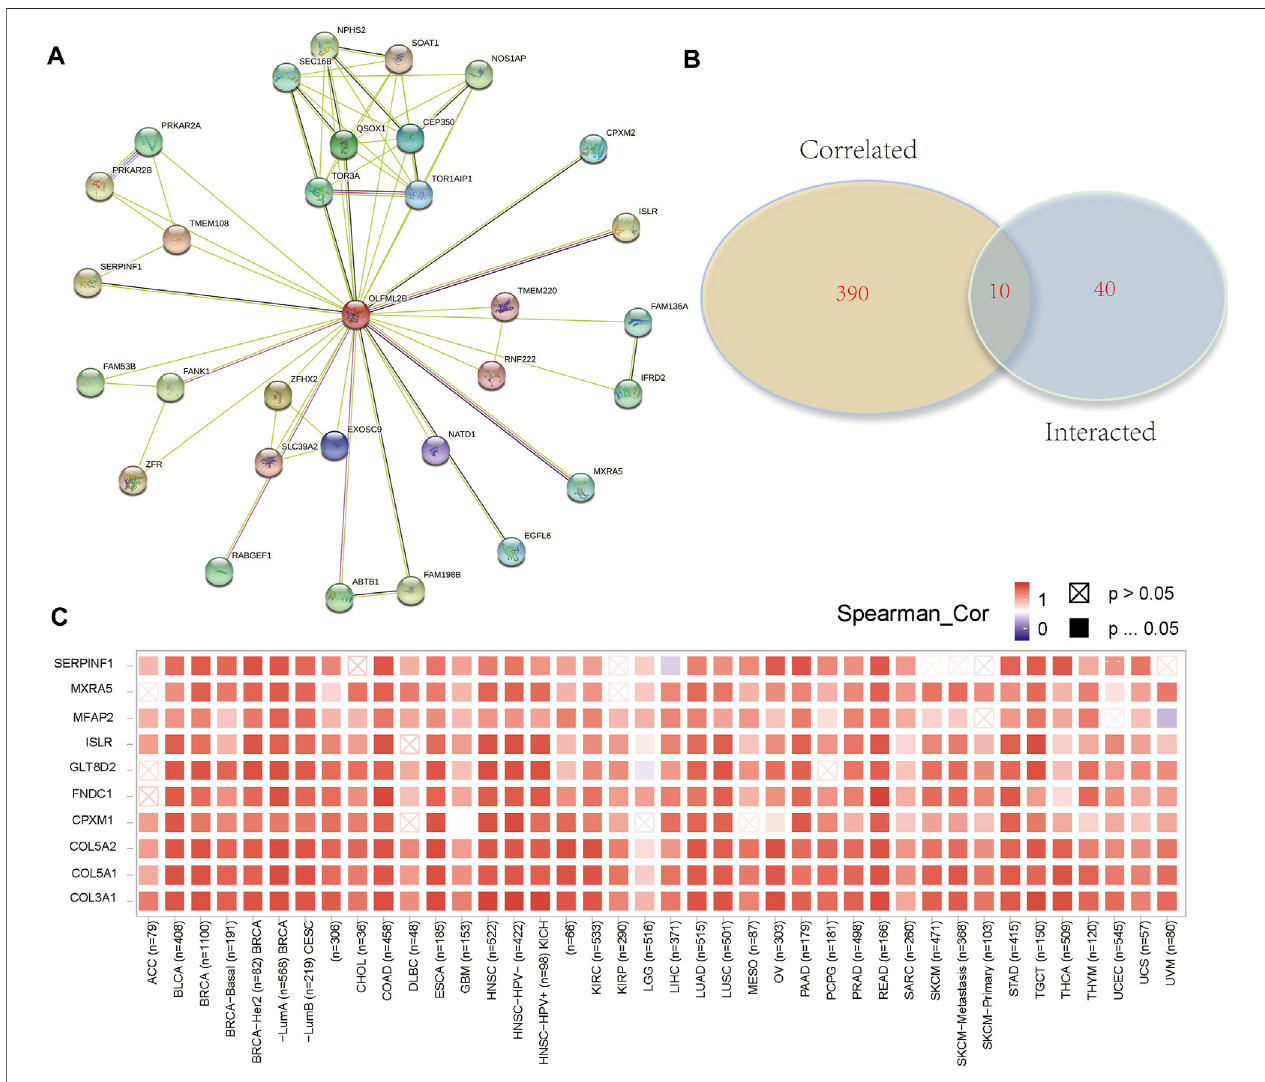
FIGURE 7 | OLFML2B-associated gene enrichment analysis. (A) PPI network of OLFML2B. (B) Venn diagram analysis. (C) Heatmap of intersected genes.